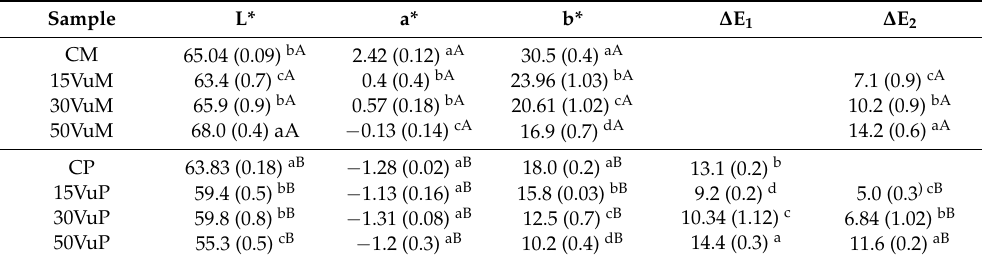
Table 2. Mean values (and standard deviations) of color coordinates (L*, a* and b*) and total color differences ( Δ E 1 and Δ E 2 ) of the mixtures (M) and powder (P) with different concentrations (15, 30, and 50%) of Vigna unguilata (Vu) and the respective controls (CM and CP) hydrated for 18 h according to SWE methodology.